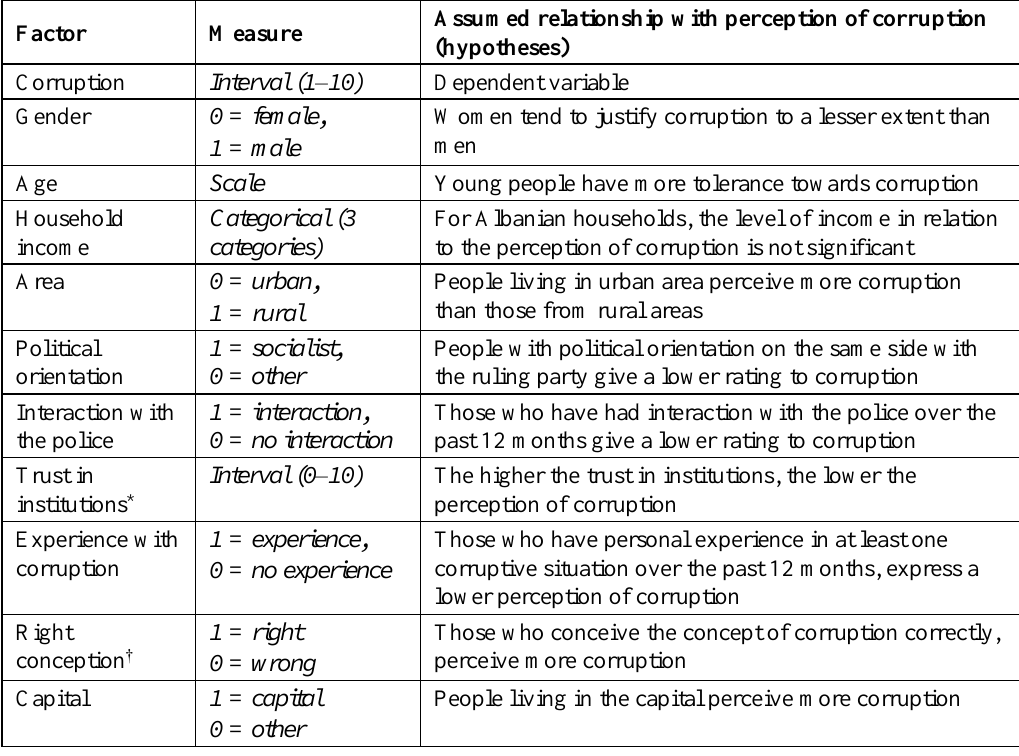
Table 1. Factors and Hypotheses (Operationalization of the